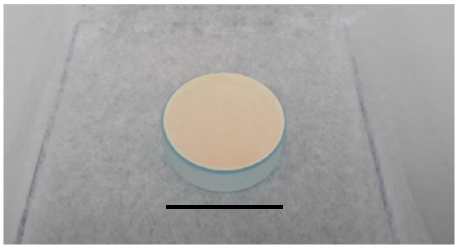
Figure 12. Photo picture of a coated chirped mirror; black line is 25 mm in length.